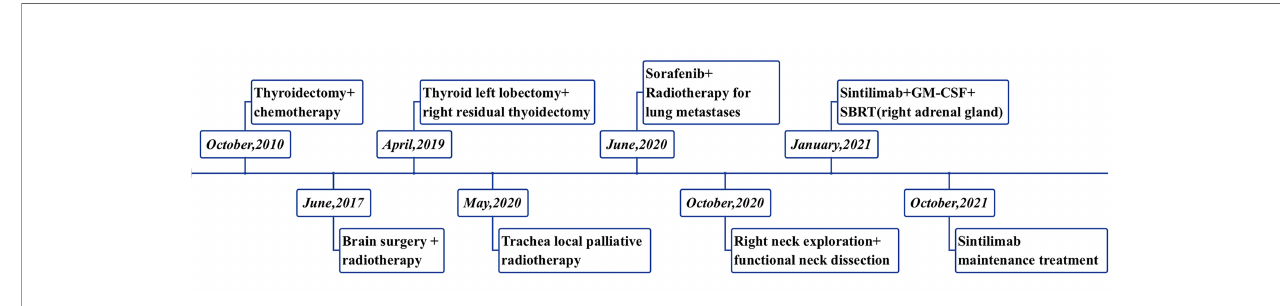
FIGURE 1 | Timeline of the case